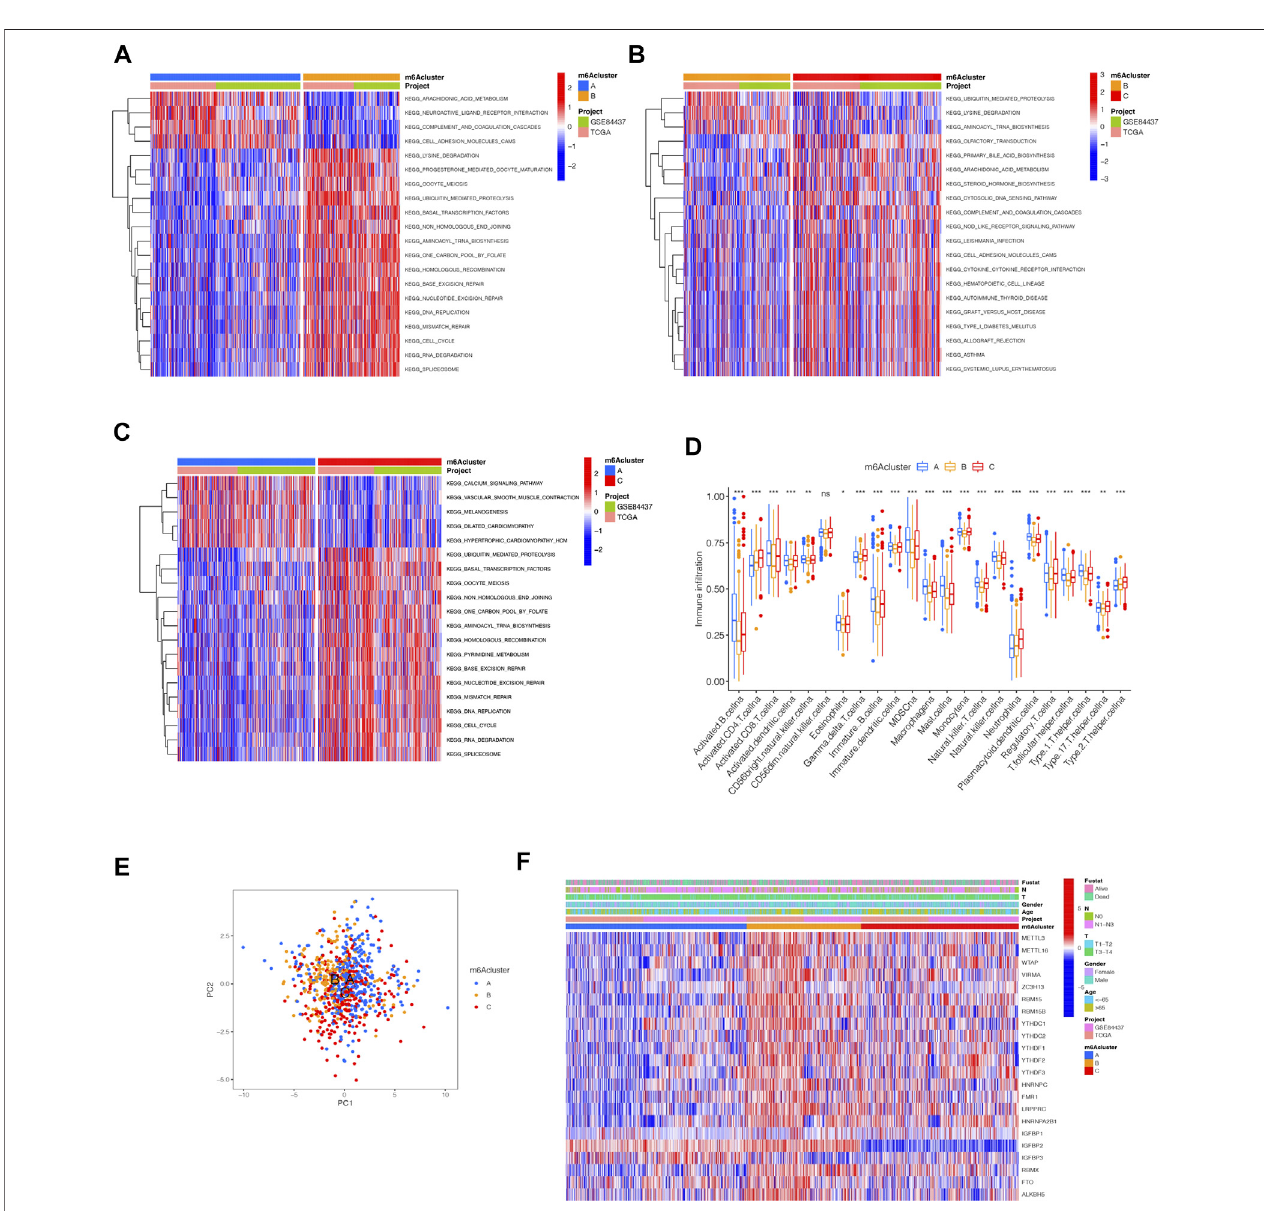
FIGURE 3 | Distinct immune landscapes in m6A modi fi cation patterns and the biological characteristics of each pattern. (A – C) GSVA analyzed the differences between functional pathways in m6A modi fi cation patterns (adjusted p -value < 0.05). (A) , m6Acluster A vs. m6Acluster B; (B) , m6Acluster B vs. m6Acluster C; (C) , m6Acluster A vs. m6Acluster C. (D) Differential expression analysis of23 immune cells among three m6A modi fi cation patterns. The asterisks represented the statistical p value( ppp p < 0.0001, pp p < 0.01, p p < 0.05). (E) ScatterplotofPCAform6Amethylationmodi fi cationpattern. (F) Unsupervised clusteringof23m6Aregulatorsof